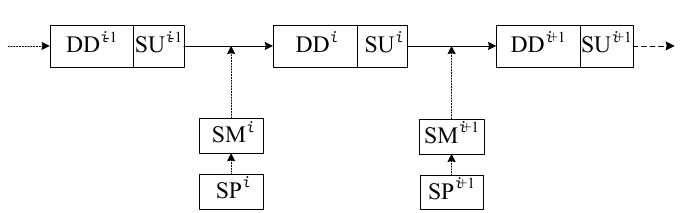
Figure 8. The sequences of SM and